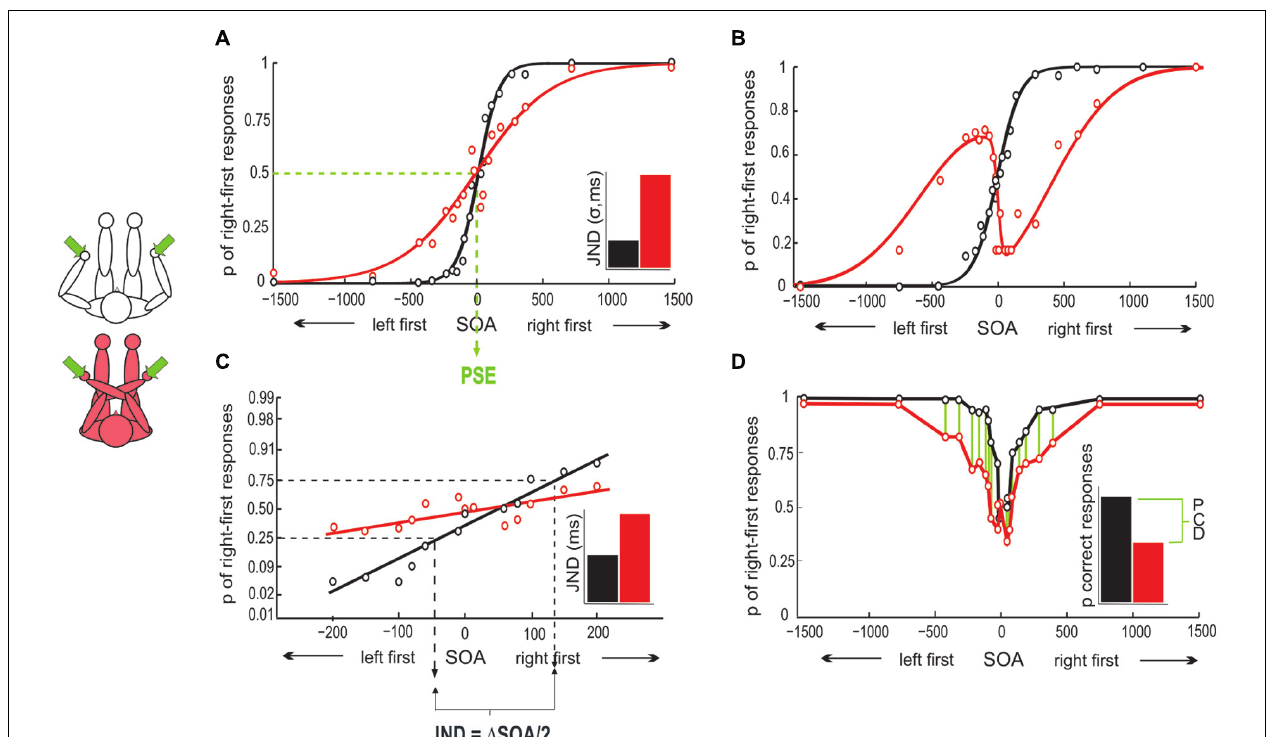
Hypothetical example of N-shaped response probability profile in a crossed posture. (C) Probit analysis of the data in (A) . Right-first response proportions are linearized by probit transformation and regressed thereafter. The crossing effect is evident in the difference of slopes between conditions. The JND is derived by projecting the 25 and 75% right first probabilities onto the SOA axis. (D) Data in (A) can be plotted as proportion-correct rather than right-first. The crossing effect can then be assessed as the proportion correct difference (PCD, proportion correct difference, see Cadieux etal., 2010) in the two